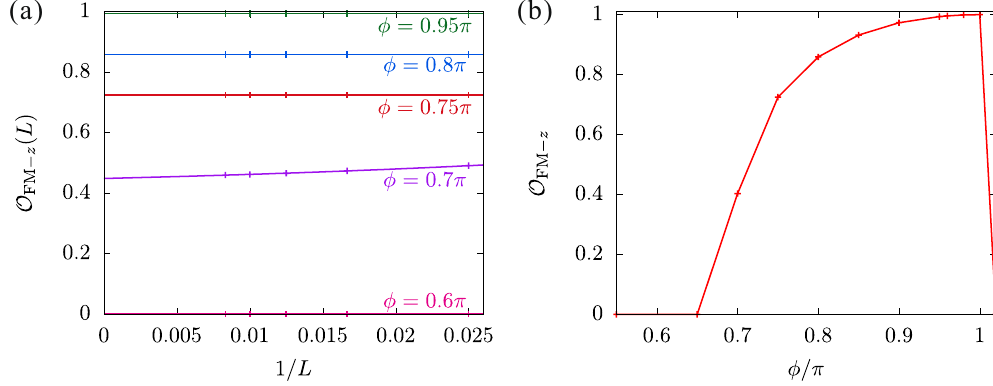
Figure 4. ( a ) Finite-size scaling analyses of the FM- z order parameter with polynomial fitting functions. ( b ) Extrapolated values of the FM- z order parameter  −